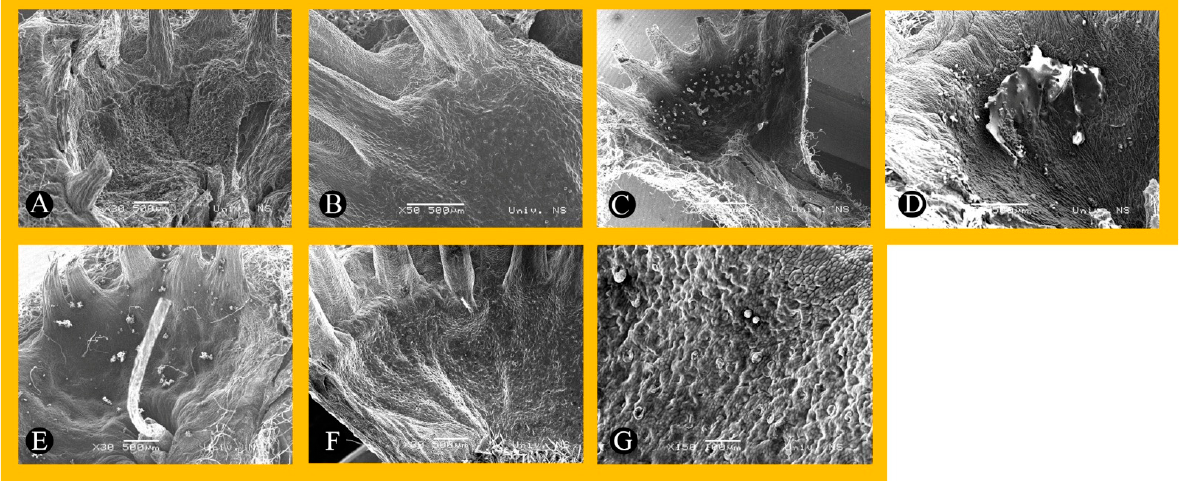
Figure 4. SEM micrographs showing plate-shaped structure of the hypanthium indicating nectarif- erous area inside pear cultivar flowers. ( A ) Kieffer (resistant) (×30), ( B ) Nijisseiki (resistant) (×50), ( C ) Poire de Cure (moderately resistant), ( D ) Bella di guigno (moderately resistant), ( E ) Williams (susceptible), ( F ) Alexander Lucas (low susceptible), ( G ) Chojuro (resistant).